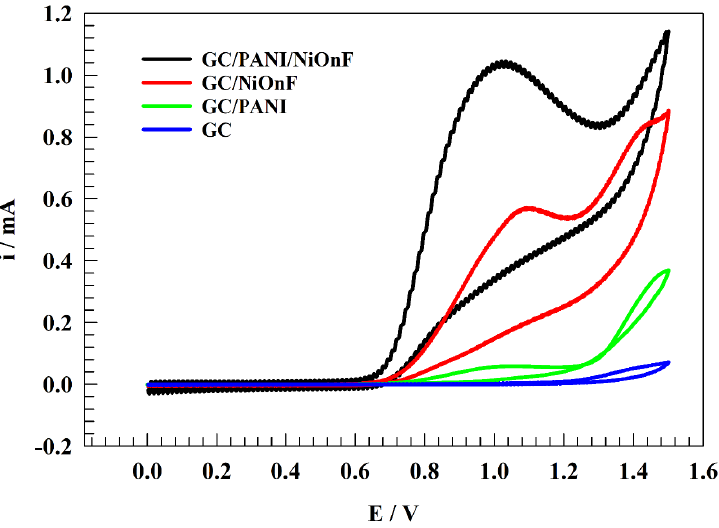
Figure 4. CVs of the different electrodes (GC/PANI/NiOnF, GC/NiOnF, GC/PANI and GC) in solution of 0.1 M PBS (pH = 7) and 0.5 mM nitrite at scan rate 20 mV s − 1 .